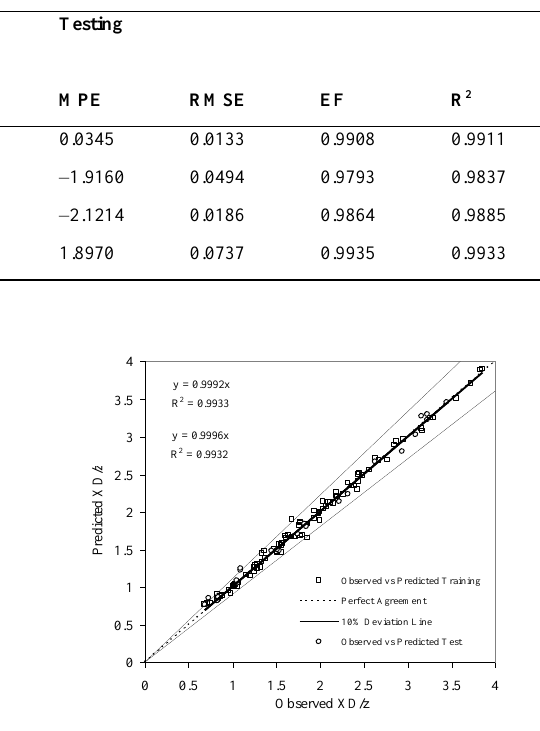
Figure 23. Comparison between observed and predicted XD/z of ANN in training and testing